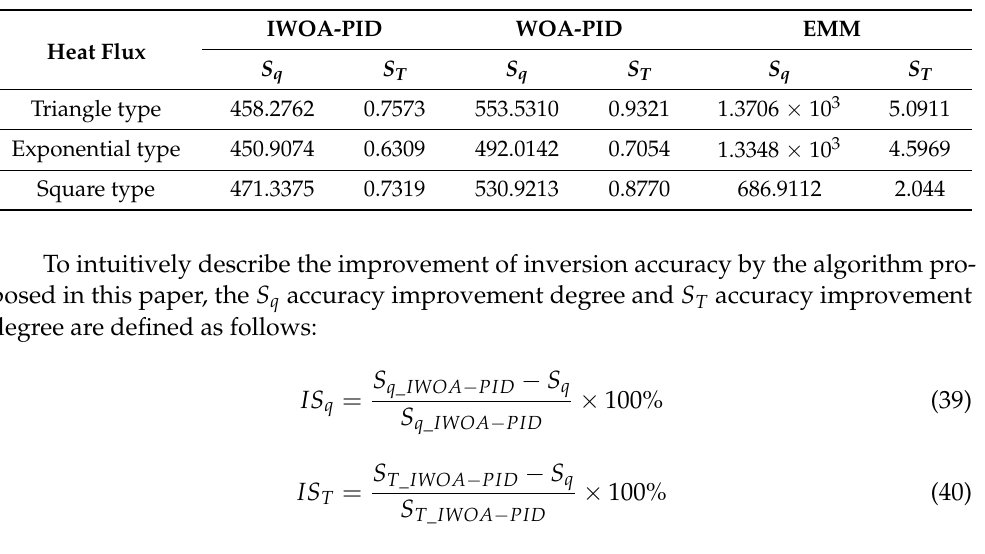
Figure 5. The inversion results and the reconstructed temperature change of measurement points under three different types of heat flux. ( a , c , e ) are inverse heat fluxes, ( b , d , f ) are TC1 temperature reconstruction. Table 1. Inversion error and reconstruction error under three heat flux types.